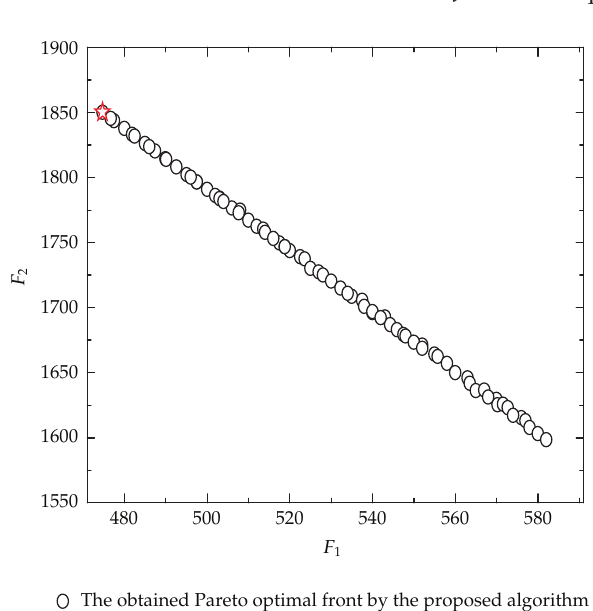
Figure 5: The obtained Pareto optimal front of Example